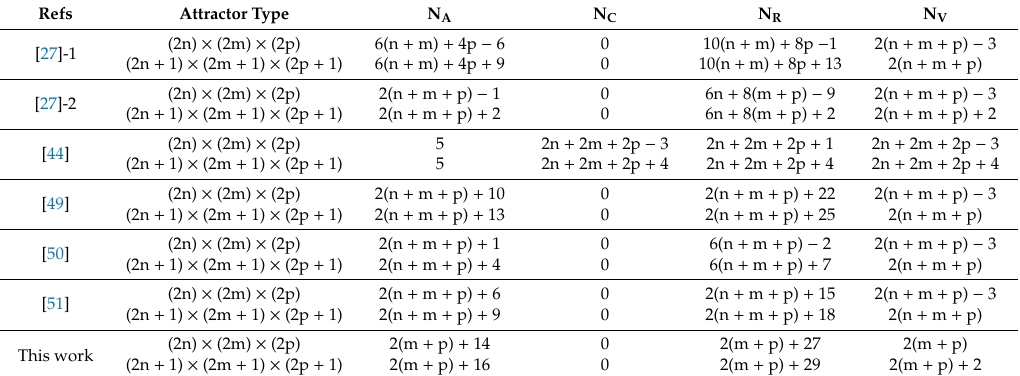
Table 2. Comparison of circuit realization of di ff erent 3-D multi-scroll chaotic